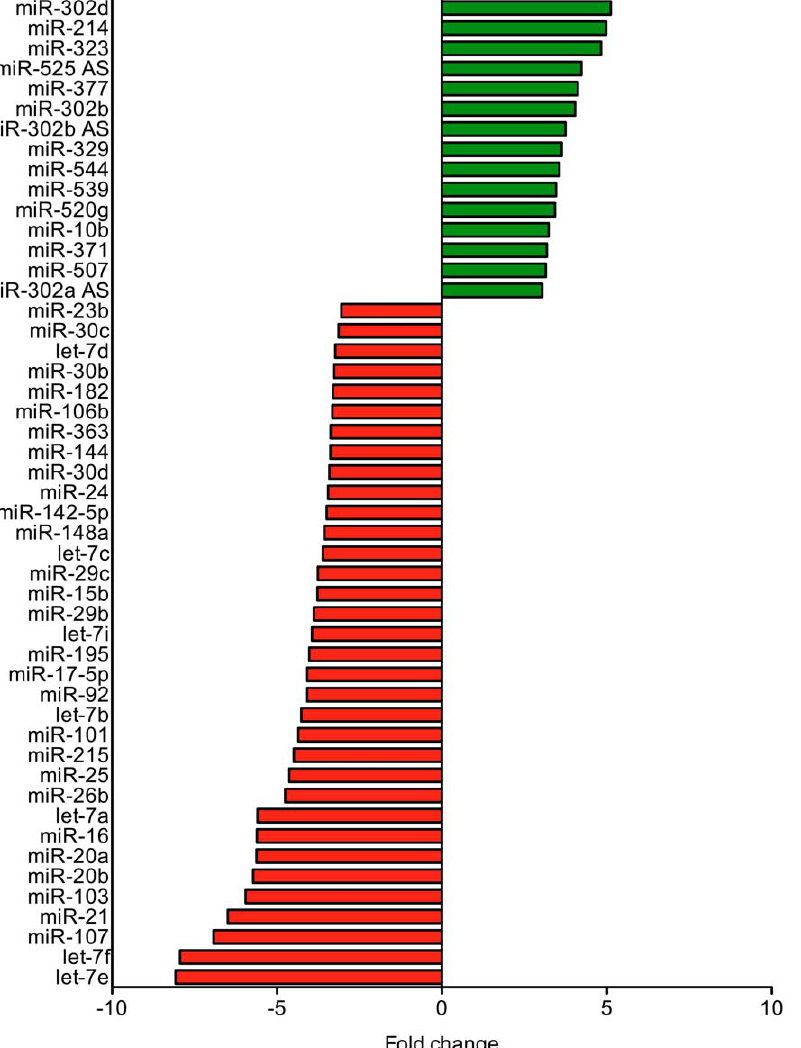
Figure 1. Deregulated miRNAs in the cellular fraction of human blood of mesothelioma patients and asbestos-exposed controls. Differences in miRNA expression were at least threefold. In patients with diagnosed malignant mesothelioma 15 miRNAs were up-regulated (green) and 34 miRNAs were down-regulated (red).